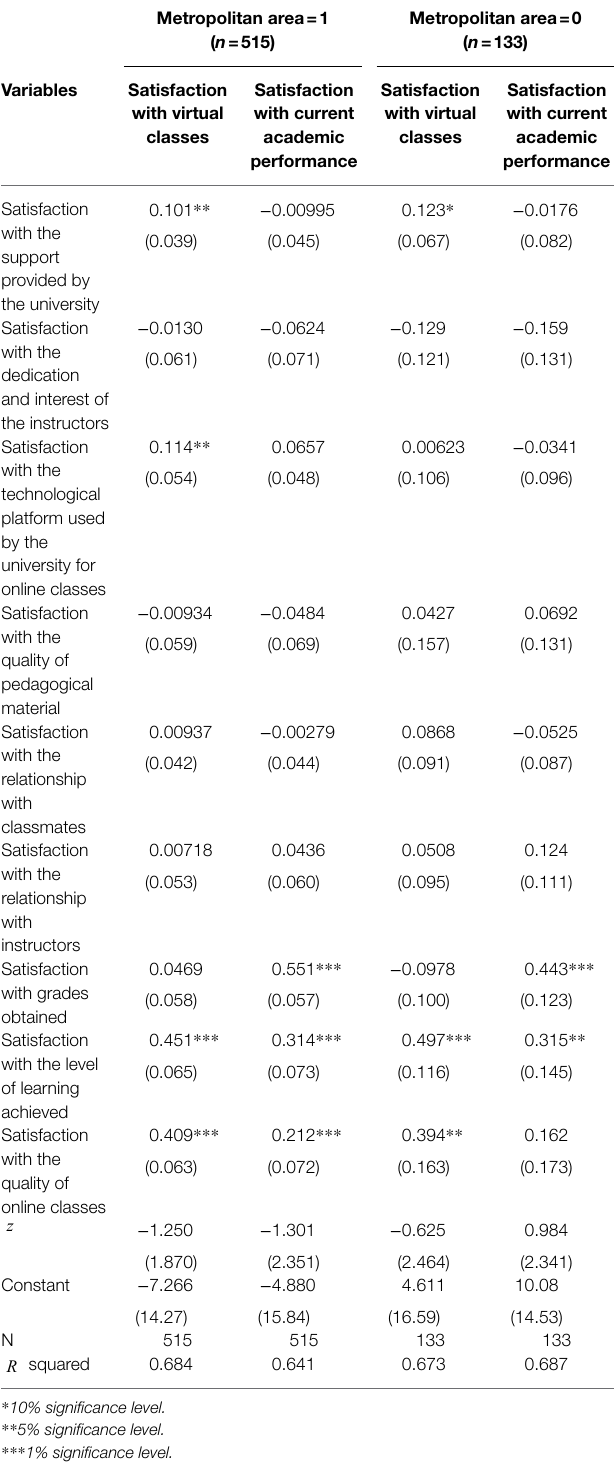
TABLE 5 | Two-layer method: estimates separated by geographical